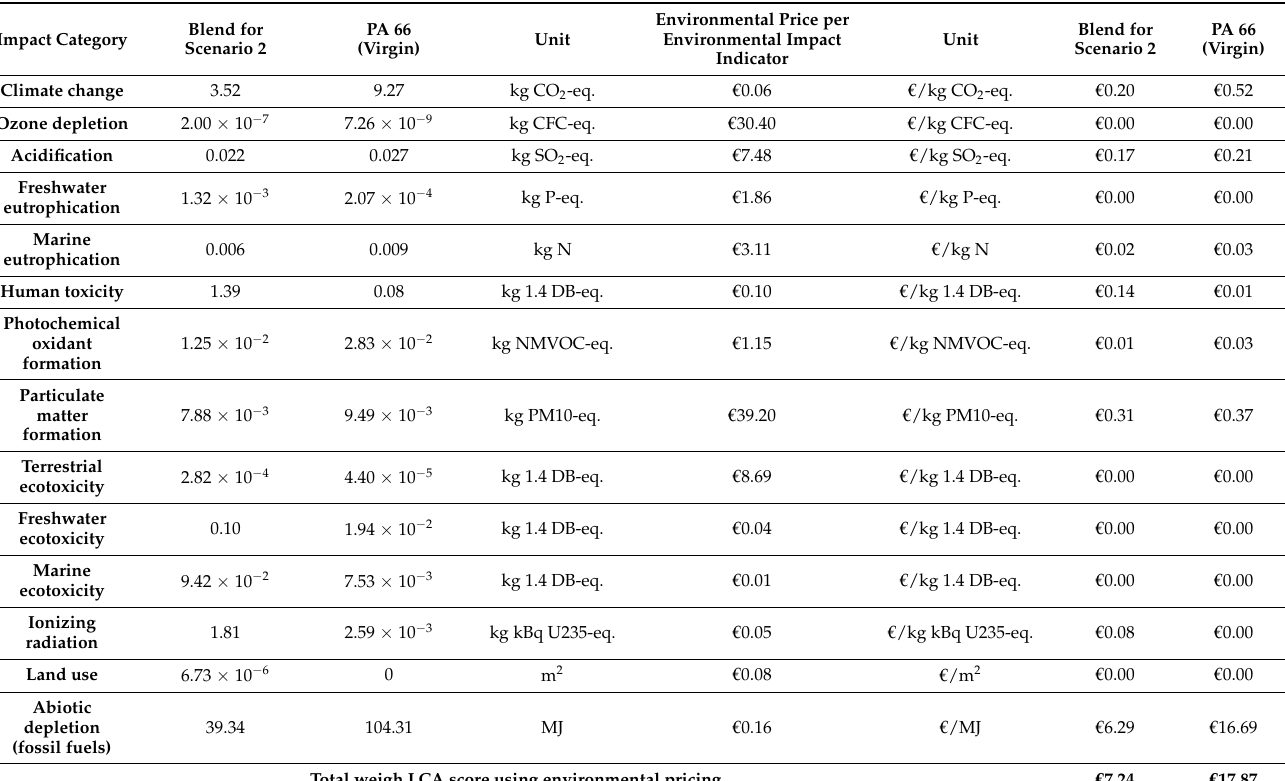
Table 8. Comparison between recycled blend (rPP/r-O-PET/TiO 2 ) and virgin PA66 for Scenario 2 on environmental pricing